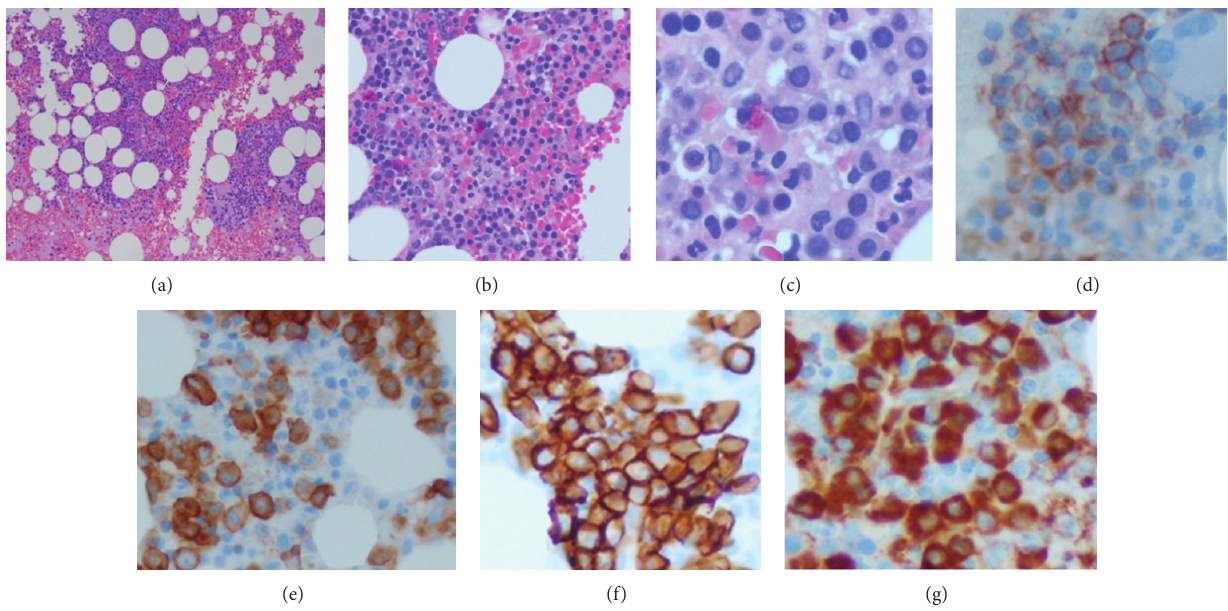
Figure 1: Right posterior iliac crest bone marrow biopsy: (a) H&E 4x, (b) H&E 10x, (c) H&E 20x, (d) CD56 20x, (e) CD117 20x, (f) CD138 20x, and (g) lambda